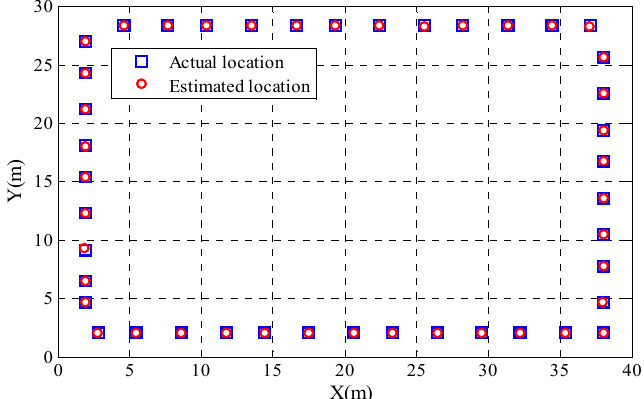
Figure 18. Actual and estimated locations for indoor LOS environments.